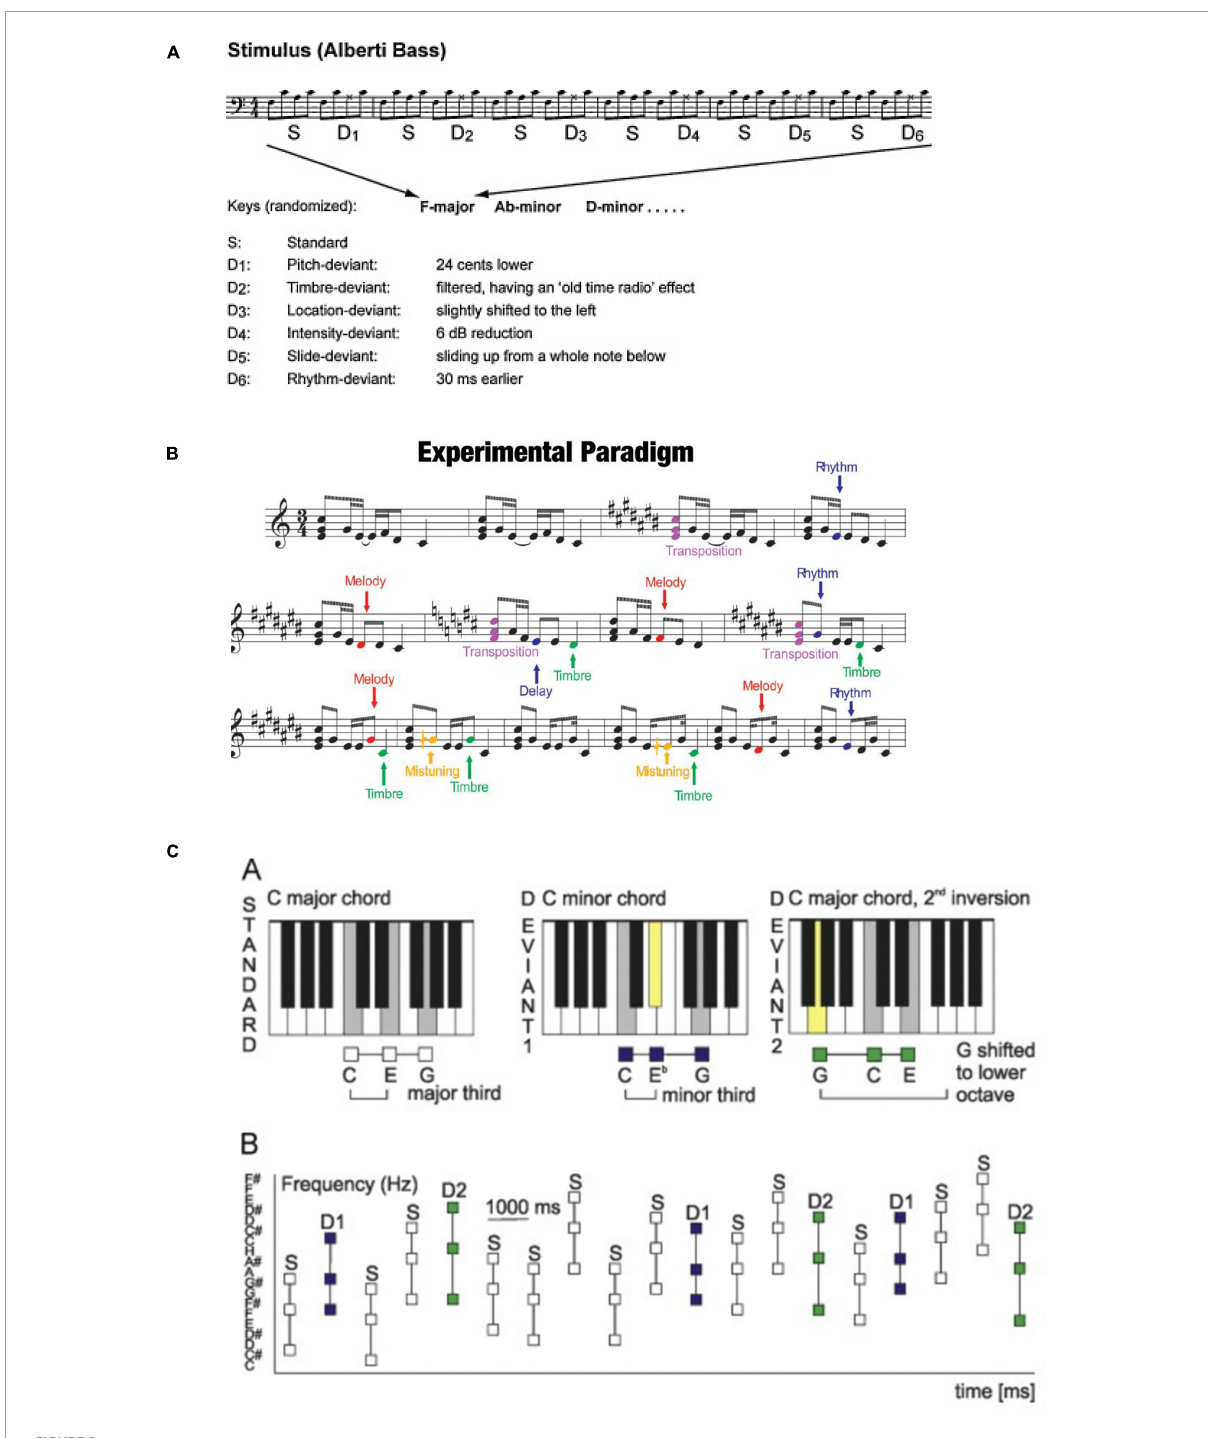
FIGURE2 (A) Musical multifeature paradigm that includes sound patterns with six different deviant tones as indicated below the score. The sequence is presented in one key for six bars and then transposed to a new key, in other words, it was presented at various pitch levels. Reprinted from Vuust et al. (2012) with permission from Elsevier. (B) Melodic multifeatured paradigm that includes short melodies with three different acoustic deviances and three different cognitive deviances as indicated on the right. Cognitive deviants change the content of the melody while acoustic deviants do not. One of the cognitive deviants is transposition, meaning that the melody is presented at various pitch levels. Reproduced by permission from Tervaniemi et al. (2014). (C) Chord paradigm with standard and two different deviant chords as indicated in the upper row. During the experiment, these three chords are presented at randomly varying pitch levels (reproduced from Virtala et al. (2014) under CC-BY